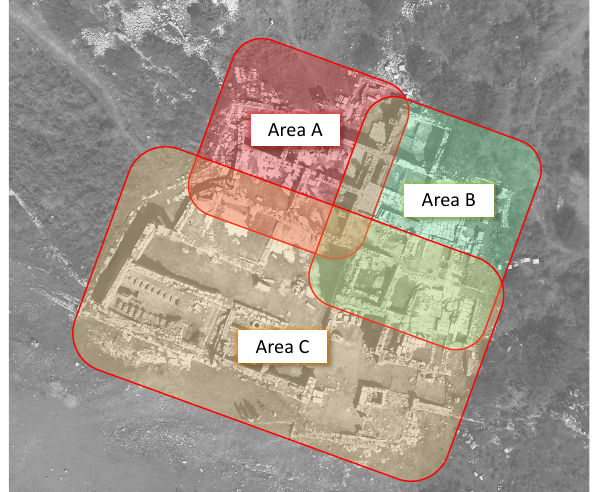
Figure 4. The three areas of scan acquisition.